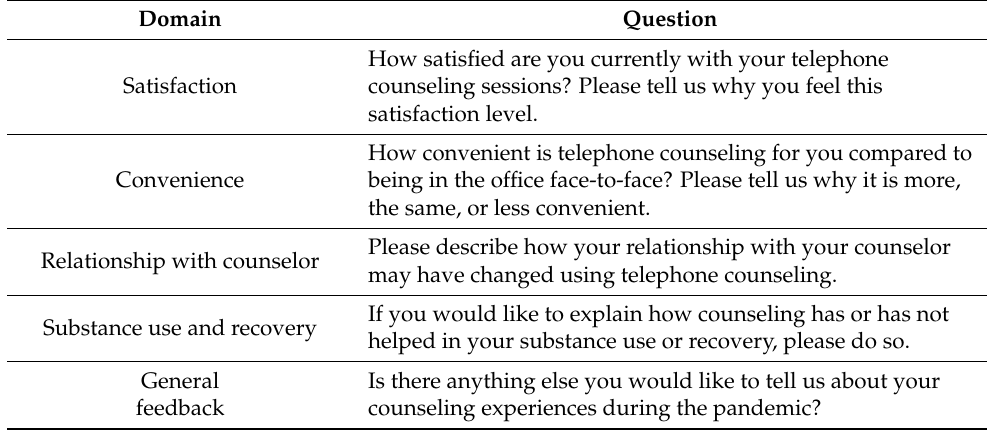
Table 1. Open-ended questions.